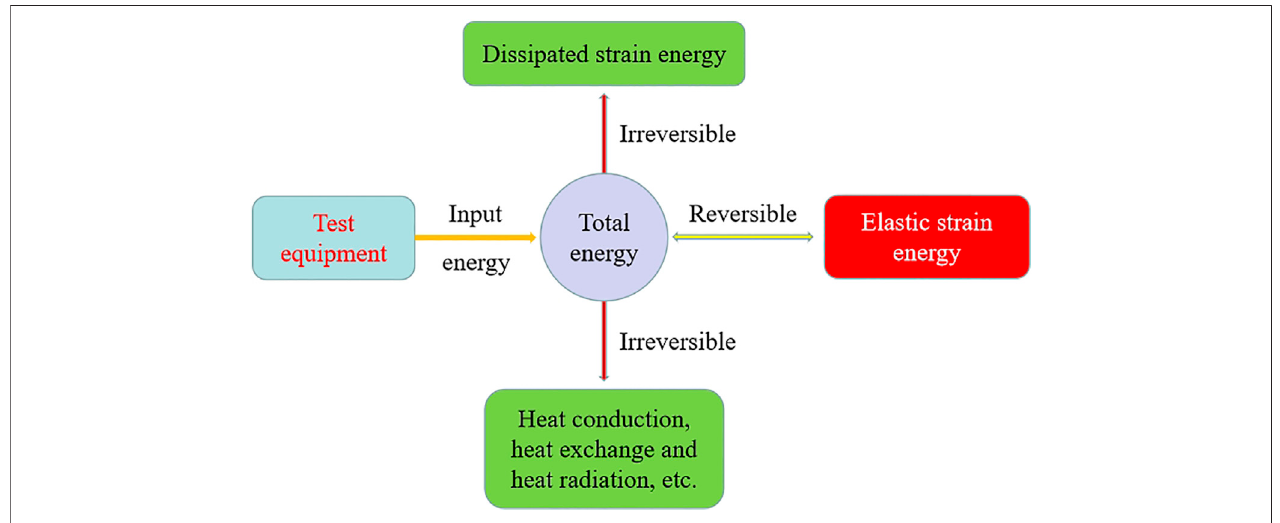
FIGURE 1 | Schematic diagram of energy conversion in rock.